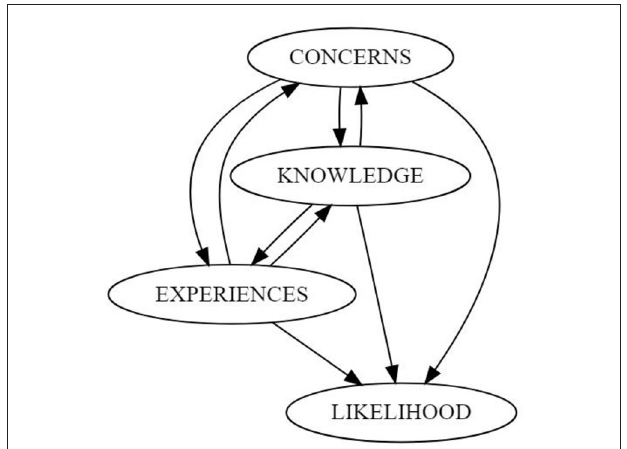
FIGURE 1 | A conceptual model to understand the influences of likelihood to install additional GI features in private residential outdoor space based on the constructs of concerns, knowledge, and experiences, which include measures such as environmental concerns, knowledge of gardening and uses of outdoor space, among others (see Figure 2